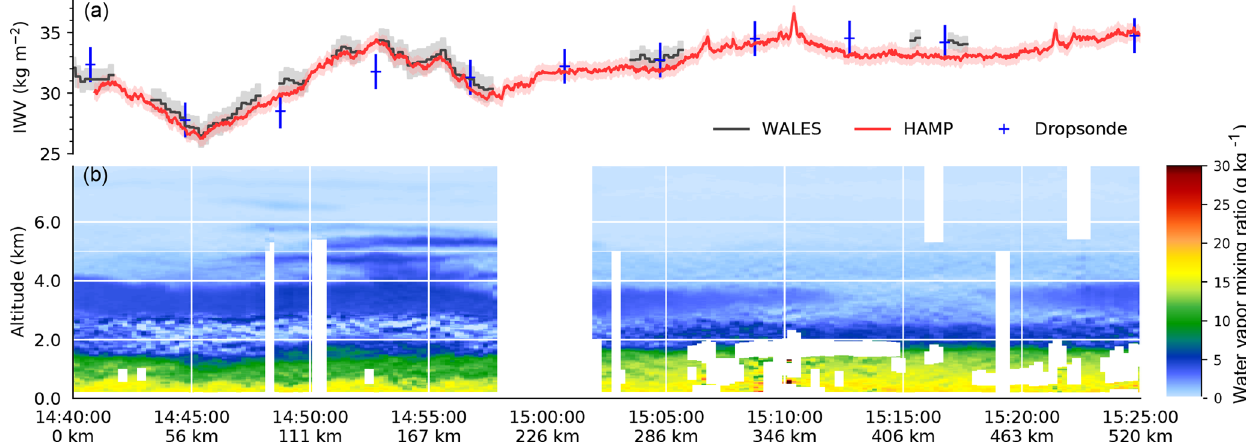
Figure 4. Water vapor time series from NARVAL2 research flight 6 on 19 August 2016. (a) IWV time series by HAMP, WALES, and dropsondes with their uncertainties. (b) WALES water vapor profiles. White areas denote masked lidar data. The scene represents a circle around 14.8 ◦ N and 51.0 ◦ W over a distance of 520km.